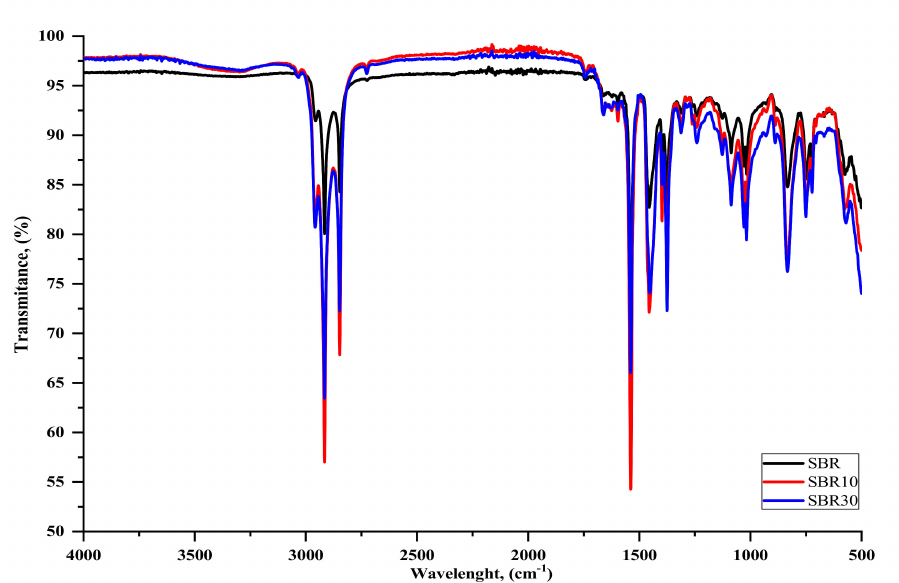
Figure 6. Comparison of the FTIR spectra for the standard sample (SBR), 10, and 30 phr BDC in SBR